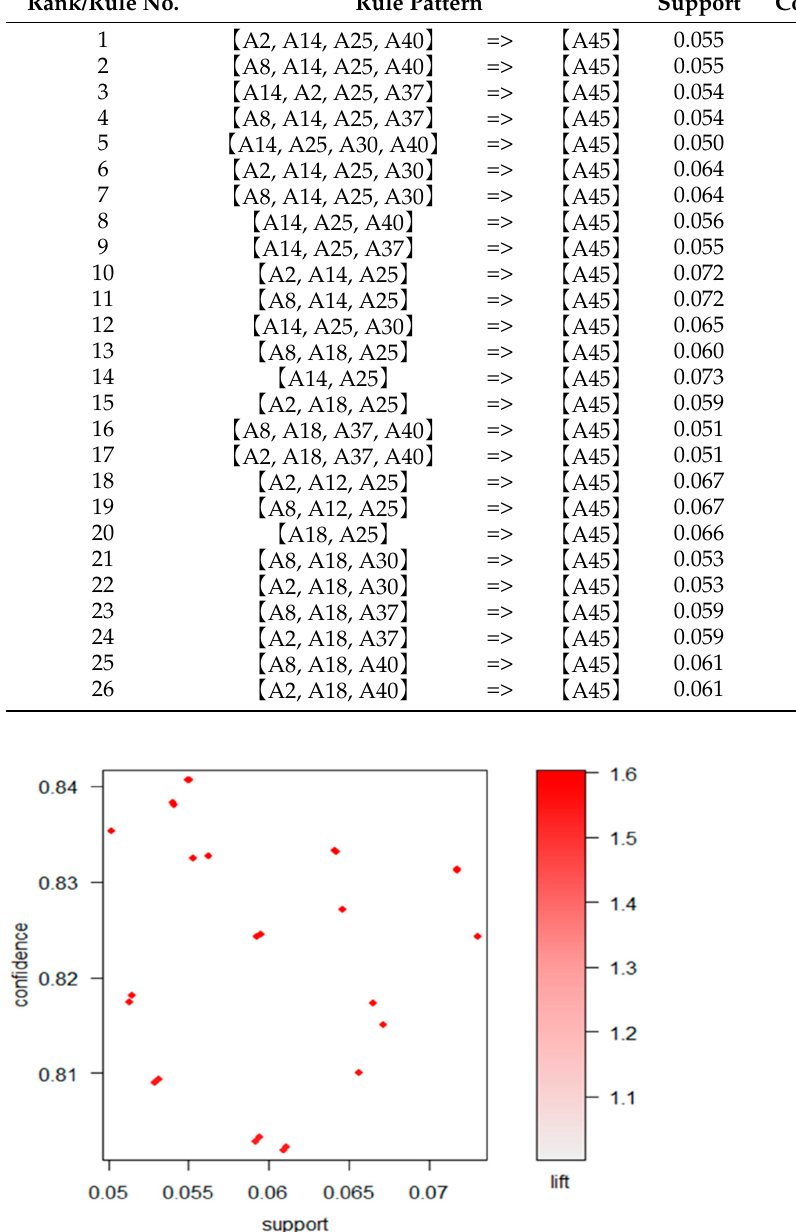
Figure 1. Scatter plot for the 26